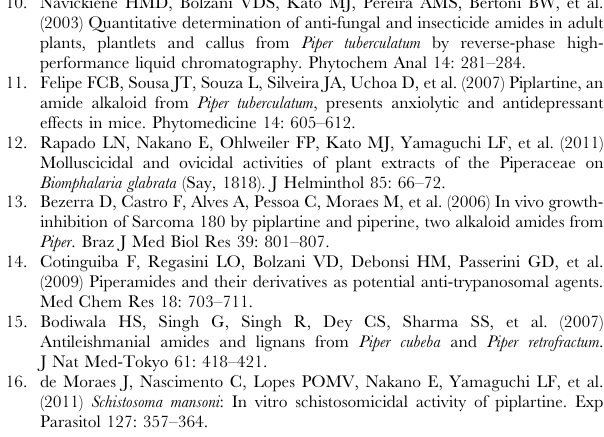
Figure S1 Scores and loadings plots from PCA generat- ed using ESIMS data of P. tuberculatum extracts. Samples, which represent extracts, are labeled according to their respective activities: more activity – dot, intermediate activity – triangle and less activity – square. Figure S2 HRESI mass spectrum of piplartine with [M + Na] + =340.1128 and its fragmentation. Figure S3 Scores and loadings plots from PCA, gener- ated using 1 H NMR data, on P. tuberculatum extracts. Samples, which represent the various extracts, are labeled according to their respective activities: more activity – dot, intermediate activity – triangle and less activity – square. Figure S4 NMR spectrum of piplartine (200 MHz, Bruker). Figure S5 Scores and weights plot generated by PLS analysis. These data were obtained using autoscaled LC 50 values